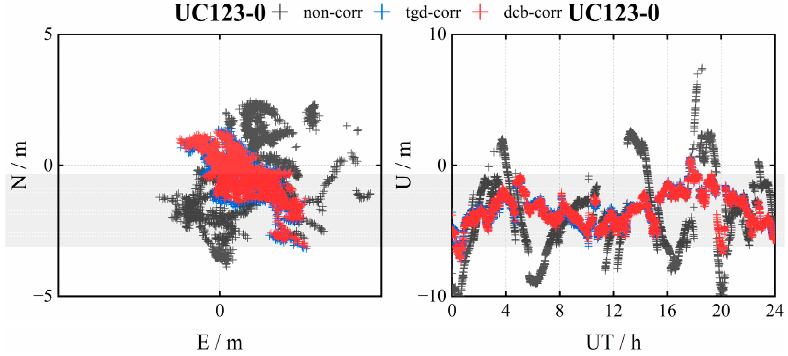
Figure 6. SPP positioning error of UC123-0 at AREG.